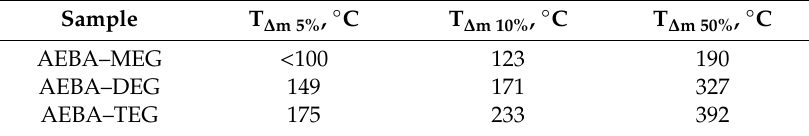
Figure 2. TGA curves of AEBA–MEG ( 1 ), AEBA–DEG ( 2 ), and AEBA–TEG ( 3 ) in air. Table 1. Characteristics of thermo-oxidative stability of AEBA-MEG, AEBA-DEG AEBA-TEG for the heating rate of 10 ◦ C /